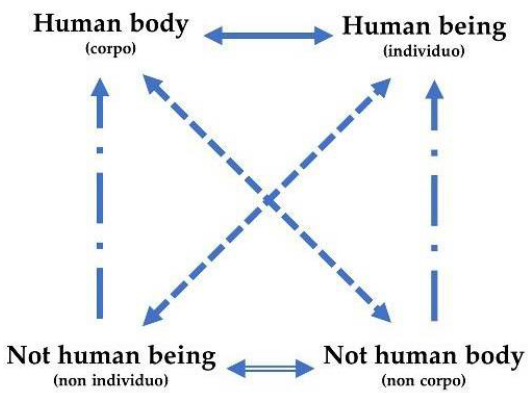
Figure 8. Greimas’ square in the experimentation of possible semiotic relationships in the Vitruvian text: human body-human being, not human being-not human